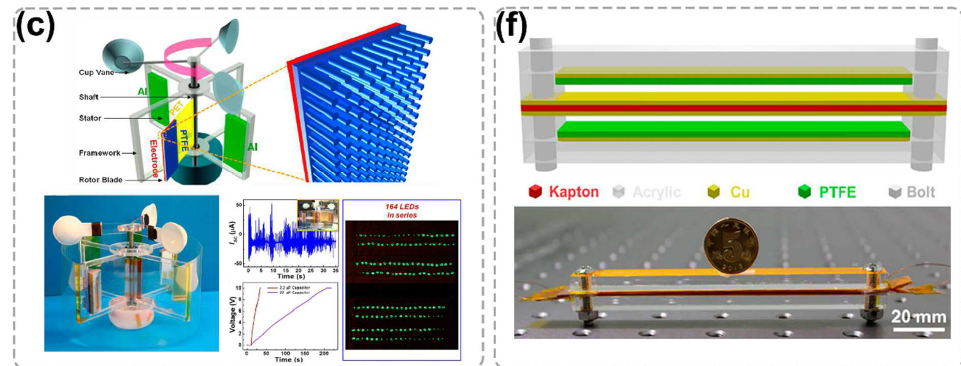
Figure 3. Typical structure and mechanism of WD-TENG. ( a ) In-plane cycled sliding mode of WD- TENG. Reproduced with permission of [28], Copyright 2015, Elsevier. ( b ) Working mechanism of rotary WD-TENG. ( c ) Rotational sweeping mode of WD-TENG. Reproduced with permission of [29], Copyright 2013, American Chemical Society. ( d ) Single-side-fixed mode of WD-TENG. ( e ) Working mechanism of flutter-driven WD-TENG. Reproduced with permission of [52], Copyright 2013, American Chemical Society. ( f ) Double-side-fixed mode of WD-TENG. Reproduced with permission of [53], Copyright 2015, American Chemical Society.